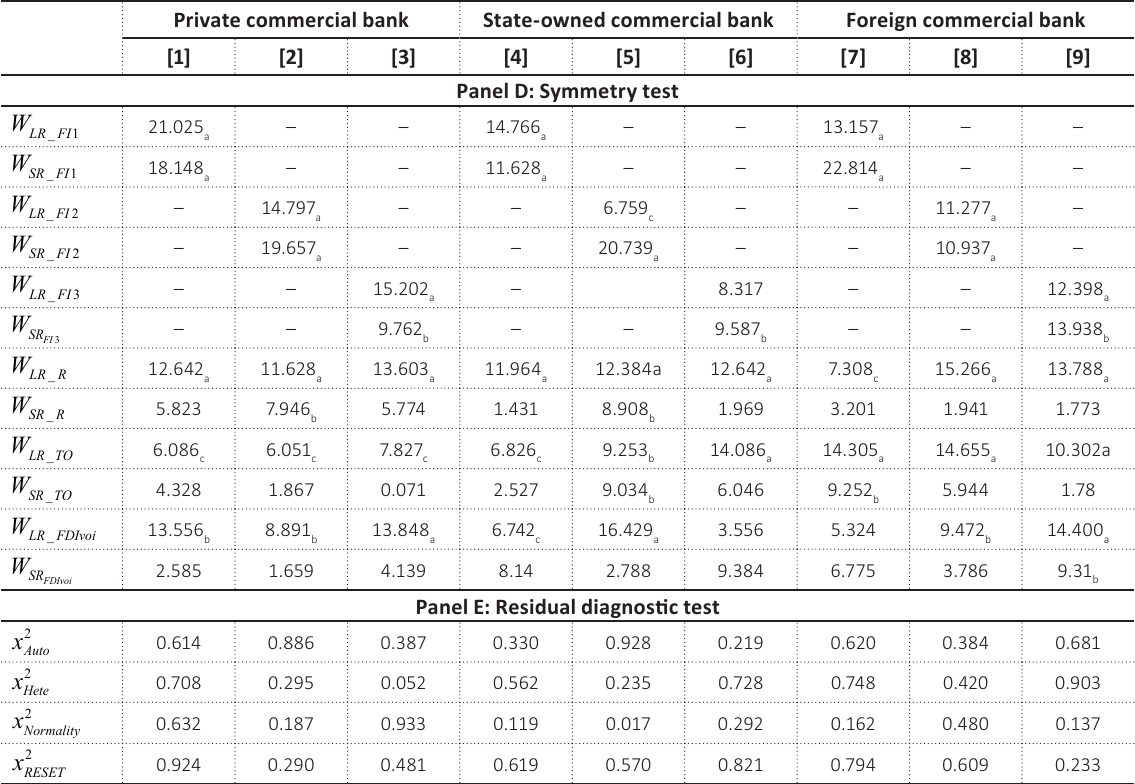
Table 7 (cont.). NARDL model estimation results